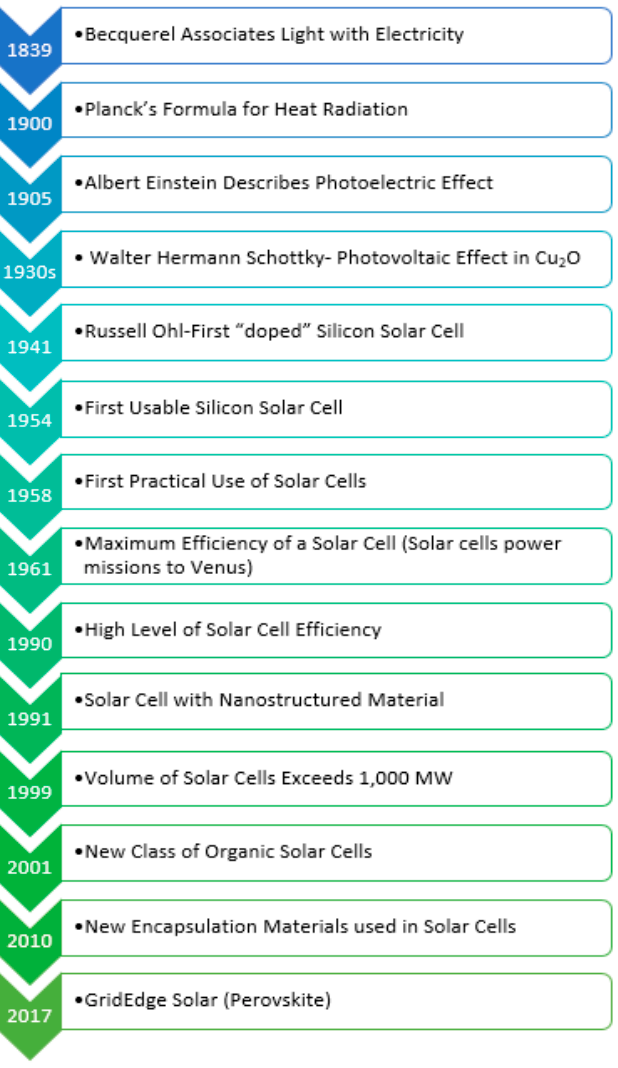
Figure 2. Chronology review of photovoltaics.